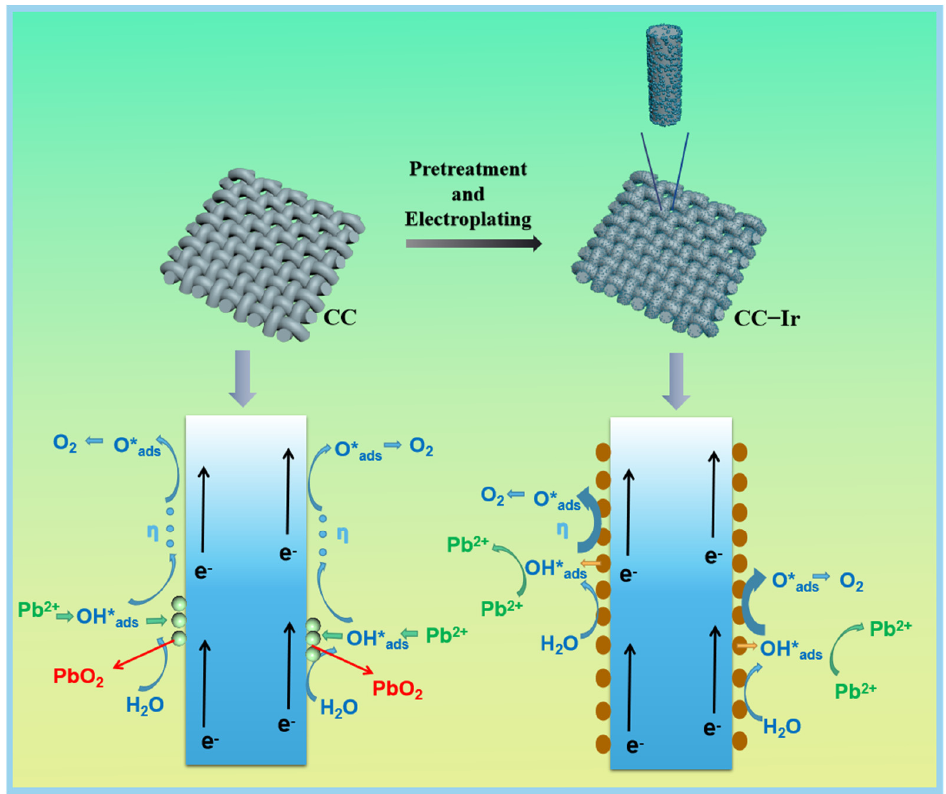
Figure 1. Schematic diagram of preparation of CC − Ir as high-performance OER catalyst for the lead recovery process.